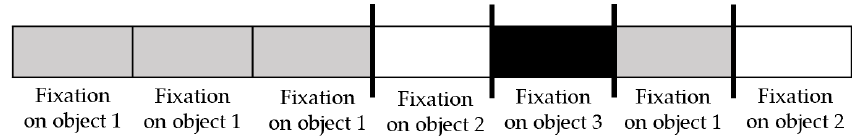
Figure 1. Example of eye transition: 4 transitions.